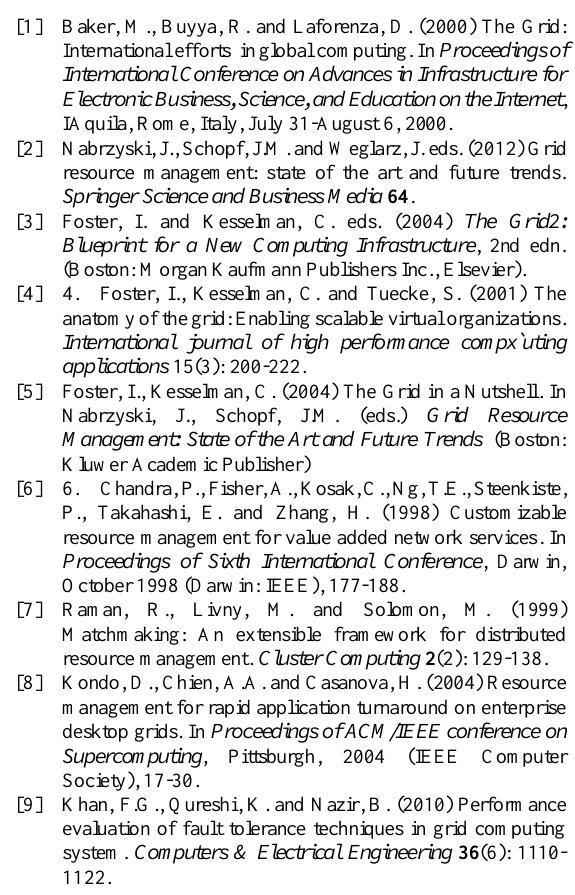
Figure 5. Comparison of existing & proposed system w.r.t Average